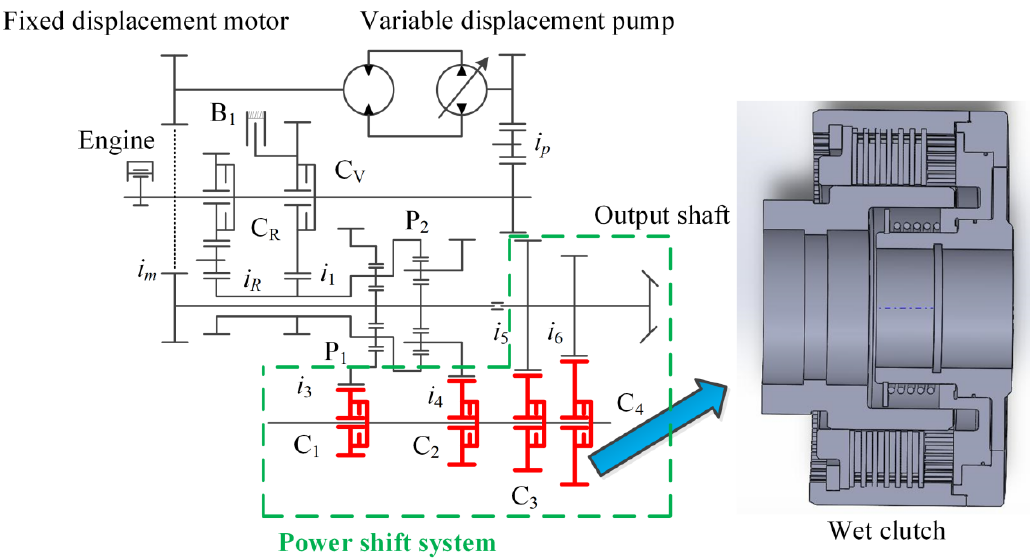
Figure 1. HMCVT for agricultural tractors, as studied in the